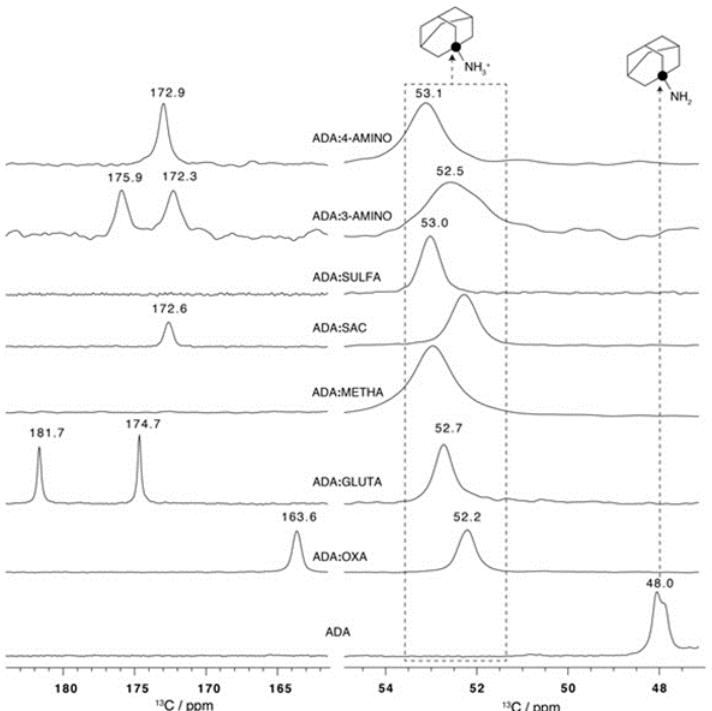
Figure 13. 15 N CPMAS NMR spectra for all salts. Red, blue, and green rectangles highlight the 15 N CS associated with ADA protonated amine, saccarin and sulfanilic acid, respectively [76].